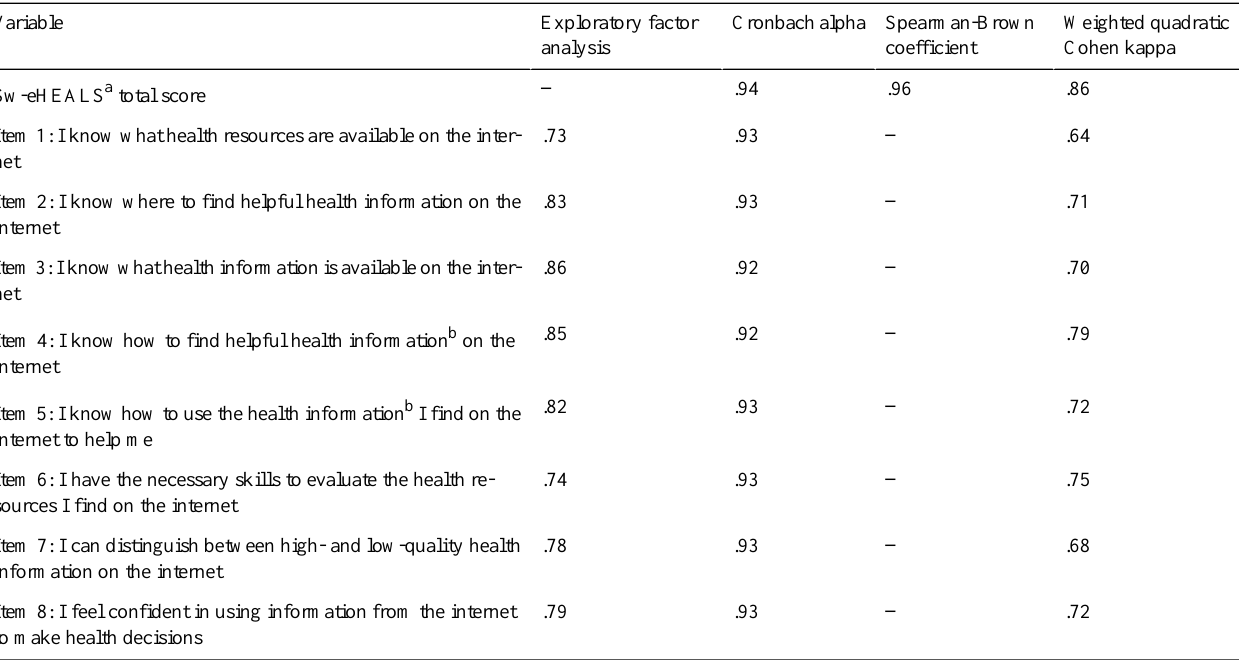
Table 4. Reliability testing: exploratory factor analysis, Cronbach alpha, Spearman-Brown coefficient, and weighted quadratic Cohen kappa for the Swedish version of the eHealth Literacy Scale sum score or individual items.